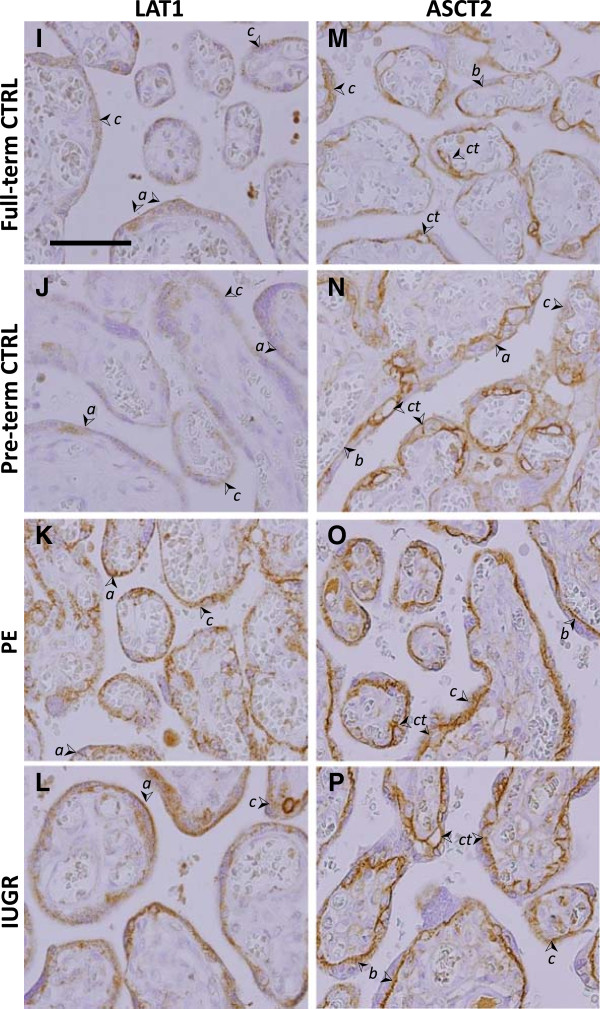
Localization of the AATs LAT1 and ASCT2. Immunohistochemistry staining for LAT1 (I-L) and ASCT2 (M-P), in placenta from Full-term control (CTRL) (I,M), Preterm control (J,N), PE (K,O), and IUGR (L,P) associated placentas. (➢ Arrow denotes syncytiotrophoblast apical MVM (a), basal membrane (b), and cytoplasm (c), or cytotrophoblasts (ct). Size bar in A = 100 μm).